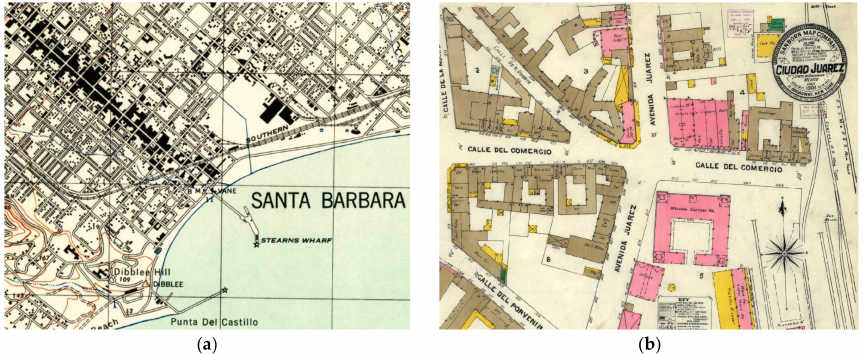
Figure 1. Examples of historical map documents: ( a ) Subsection of a USGS topographic map 1:31,680 of Santa Barbara (California, 1944) and ( b ) the Sanborn fire insurance map of the city center of Ciudad Ju á rez (Mexico, 1905).